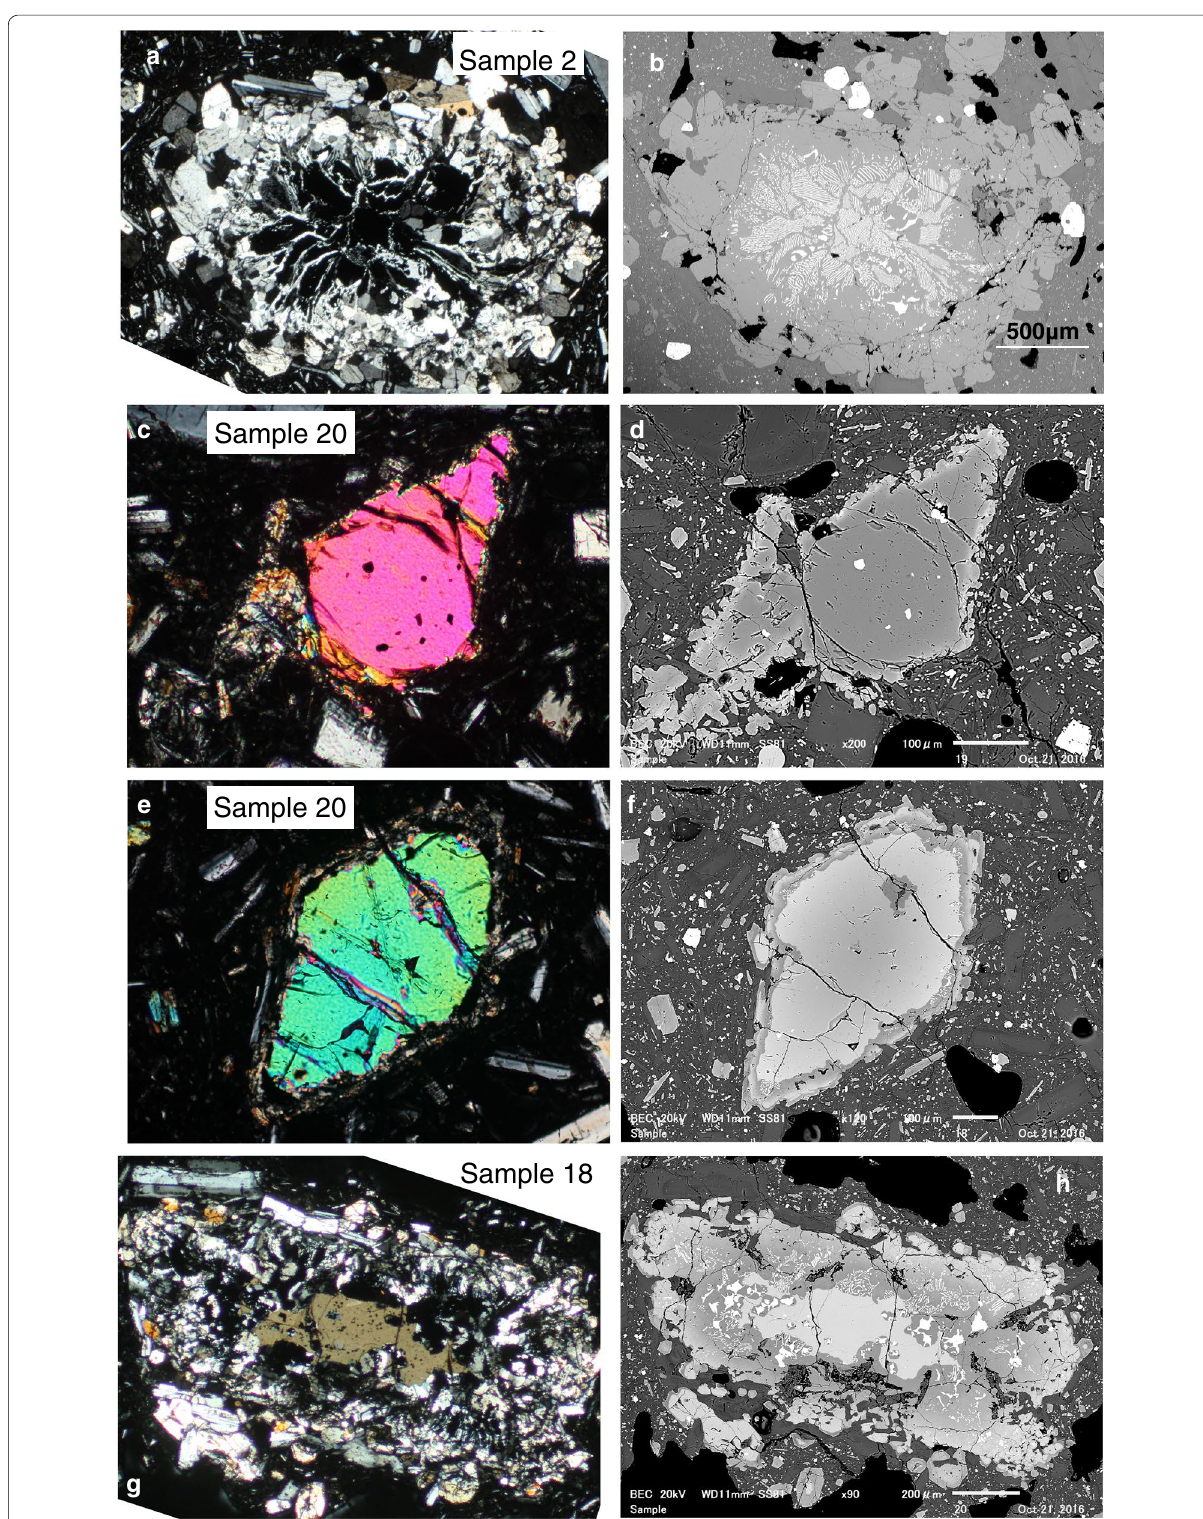
Fig. 2 Photomicrographs and BSE images of symplectites and olivine. a , b Symplectite core surrounded by an opx rim. c , d Unrimmed olivine. e , f Opx-rimmed olivine. g , h Symplectite with an olivine core and opx